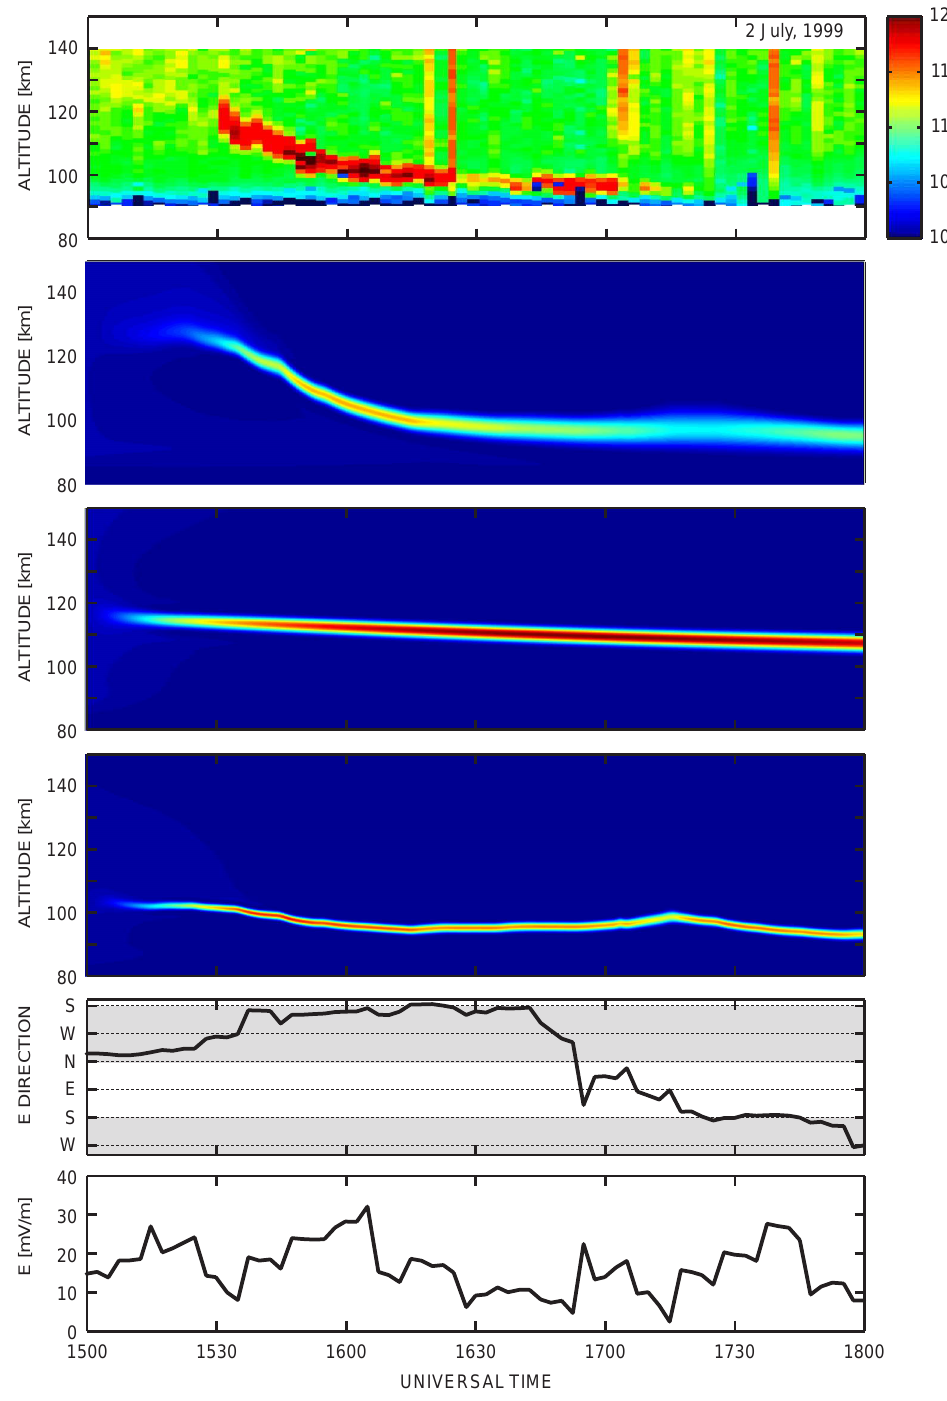
Fig. 1. Top panel: Radar observations of E region electron density above Svalbard on 2 July 1999. Second panel: Calculated time de- velopment of Fe + ion density starting from a flat background under the action of electric field only. Third panel: Same as second panel under the action of neutral wind only. Fourth panel: Same as second panel under the actions of both electric field and neutral wind. The two bottom panels: The direction and intensity of the ionospheric electric field, respectively. Here S, W, N and E mean local geomagnetic south, west, north and east. The electric field theory roughly predicts layer production when the field direction lies within the NW sector (vertical compression towards some fixed height) or within the SW sector (downward flow at all altitudes). These sectors are indicated by gray shading. For details, see the